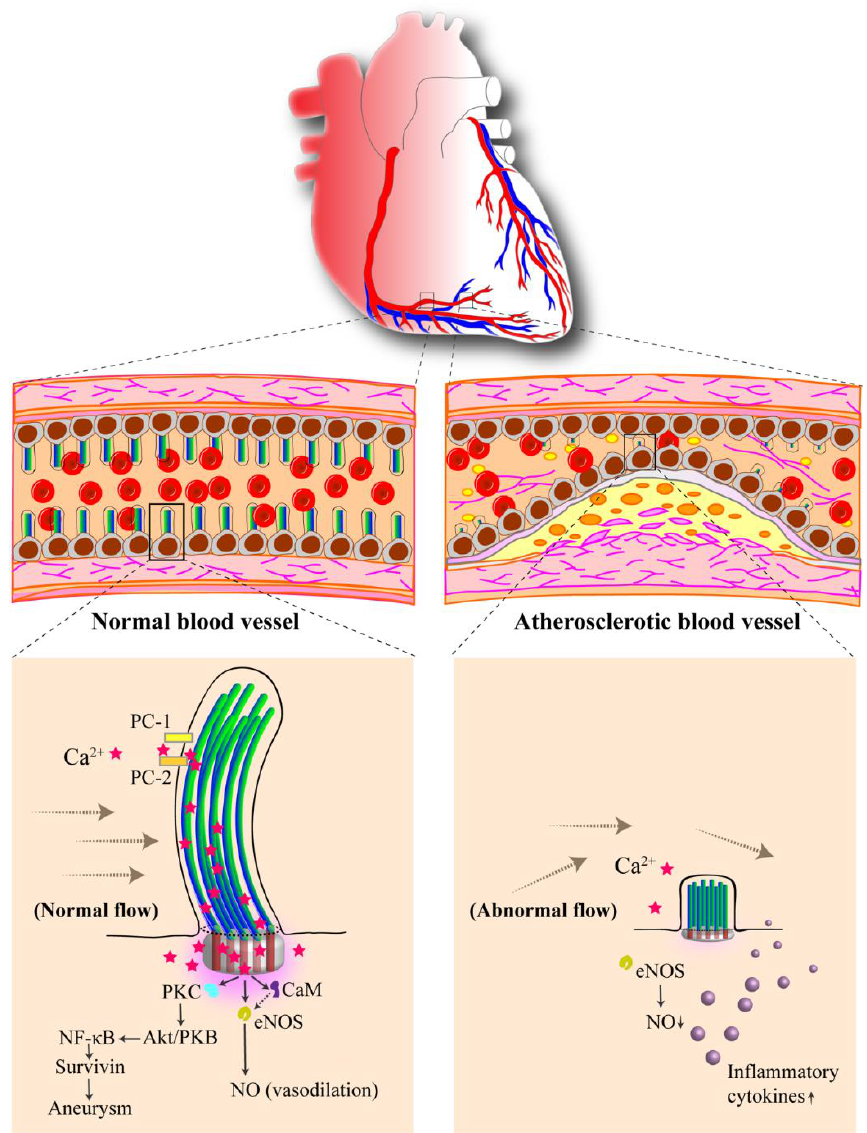
Figure 2. Vascular endothelial cilia sense the blood flow along the blood vessel. Primary cilia are structural compartments that house many mechanosensory proteins. Ciliary bending occurs upon blood-flow stimulation, and polycystin-1 (PC1) activates polycystin-2 (PC2), resulting in calcium (Ca 2+ ) influx. This generates a cascade of various protein activation and ultimately leads to endothelial nitric oxide synthase (eNOS) activation, producing vasodilator nitric oxide (NO). Calmodulin (CaM), calcium-dependent protein kinase (PKC) and serine-threonine kinase/protein kinase B (Akt/PKB) are involved in maintaining a healthy vascular structure. Abnormality in primary cilia has been proposed to promote vascular atherosclerotic formation.